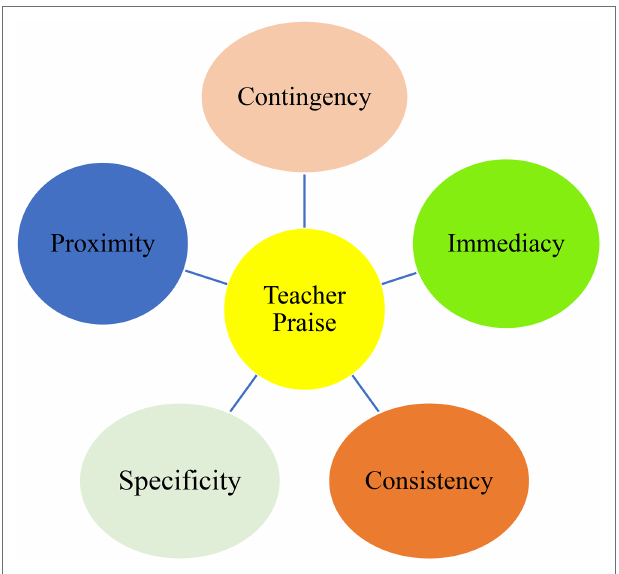
FIGURE 1 | Factors influencing teacher praise